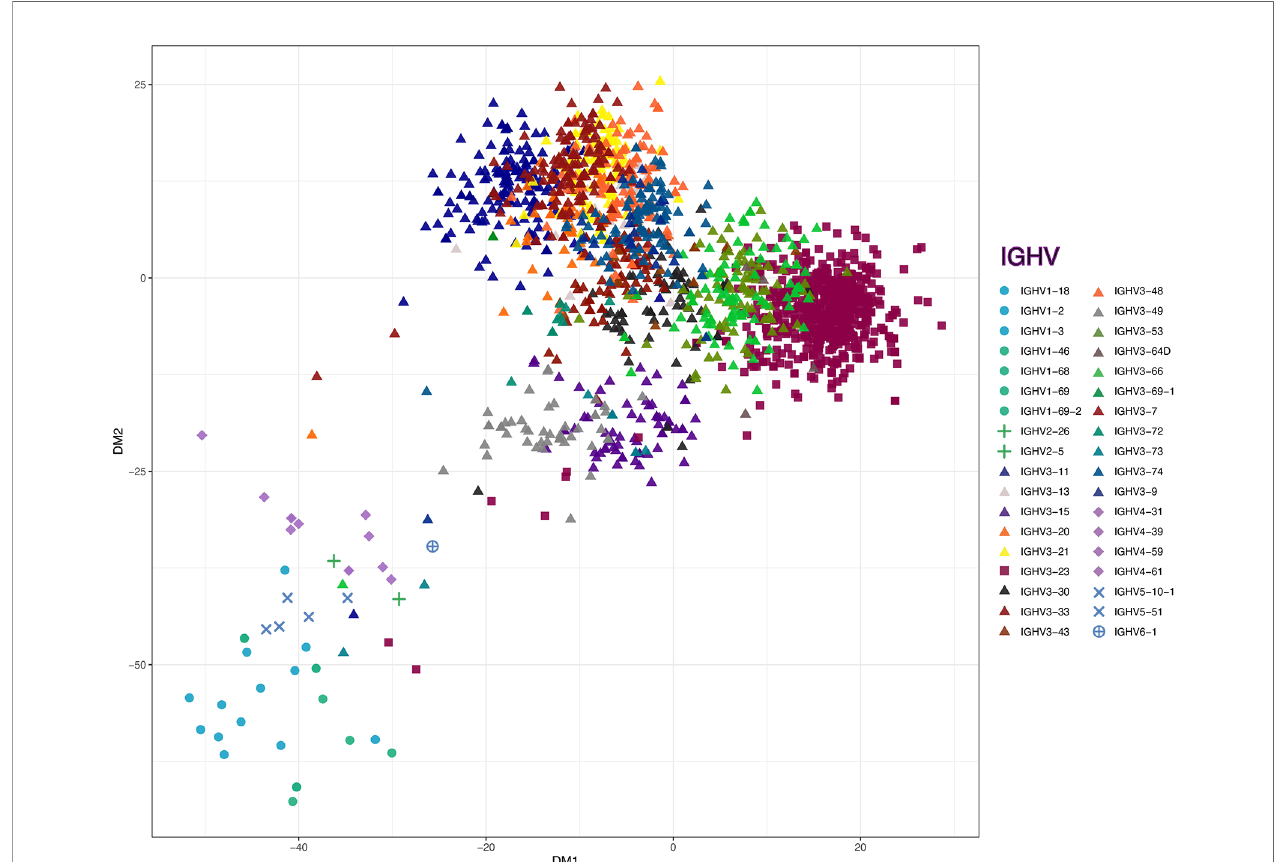
FIGURE 4 | Classical multidimensional scaling on sequence dissimilarity matrix of the VDJ regions from all of the B cell transcripts. Matrix is derived from pairwise longest common substring distance of the all VH sequences from sorted B cells, with dissimilarity between these antibody gene rearrangements depicted in two- dimension. The non-VH3 (circles - VH1, pluses - VH2, diamonds - VH4, ‘ X ’ s - VH5 and sun crosses - VH6), VH3-23 (squares) and VH3-other than from the VH3-23 germline gene (VH3-non23) (triangles) are depicted on the plot. Individual genes are marked with unique